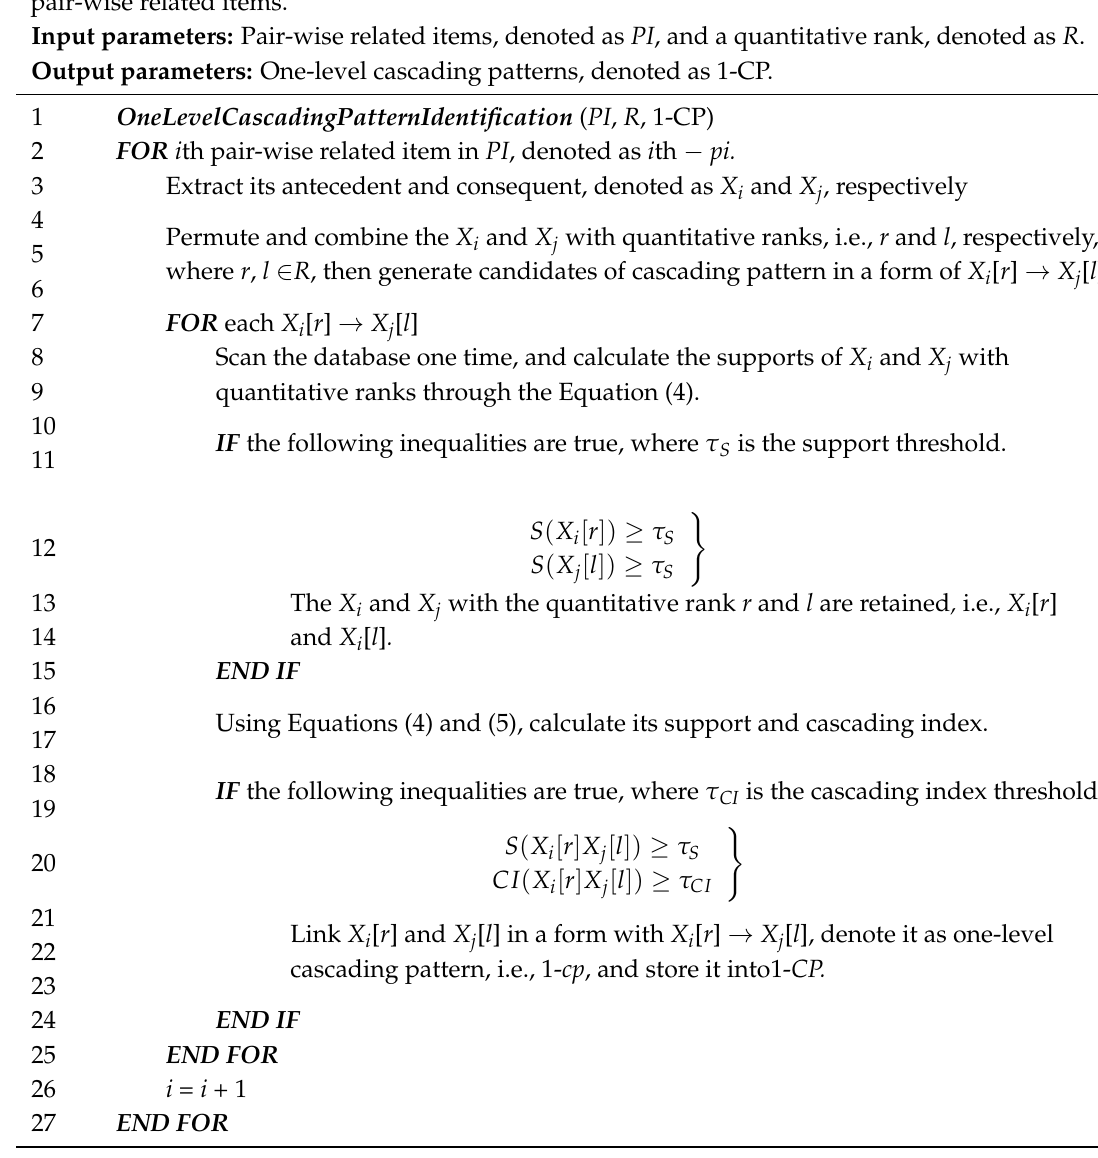
Algorithm 1. Algorithm for identifying one-level cascading patterns from pair-wise related items. Algorithm name: OneLevelCascadingPatternIdentification. Algorithm description : Identifying all one-level cascading patterns with quantitative ranks from pair-wise related